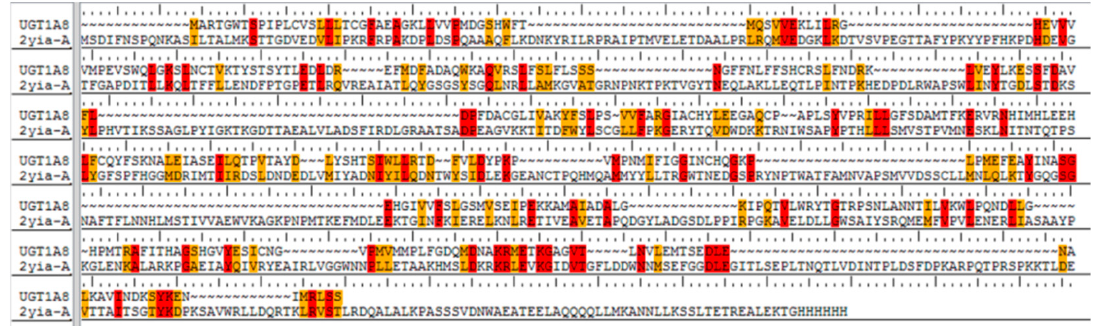
Figure 2. Sequence alignment between UGT1A8 query sequence and the template amino acid sequence of 2IYA. All the identical residues were highlighted in red color, and those similar residues in orange color respectively.